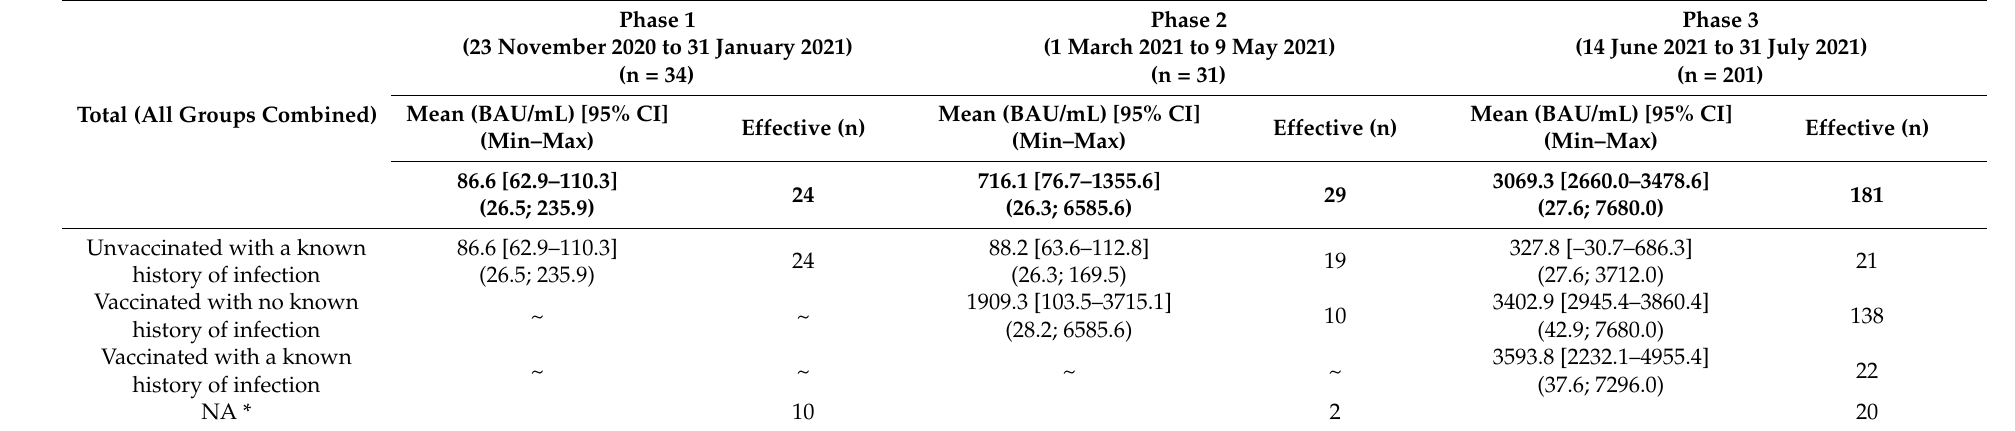
Table 4. Comparisons of IgG antibody levels to SARS-CoV-2 S protein according to participants’ immune